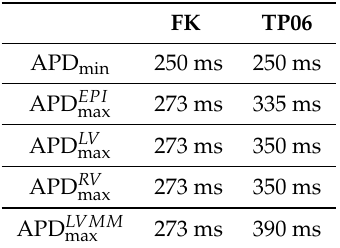
Table 1. Normalization values for FK and TP06 models.